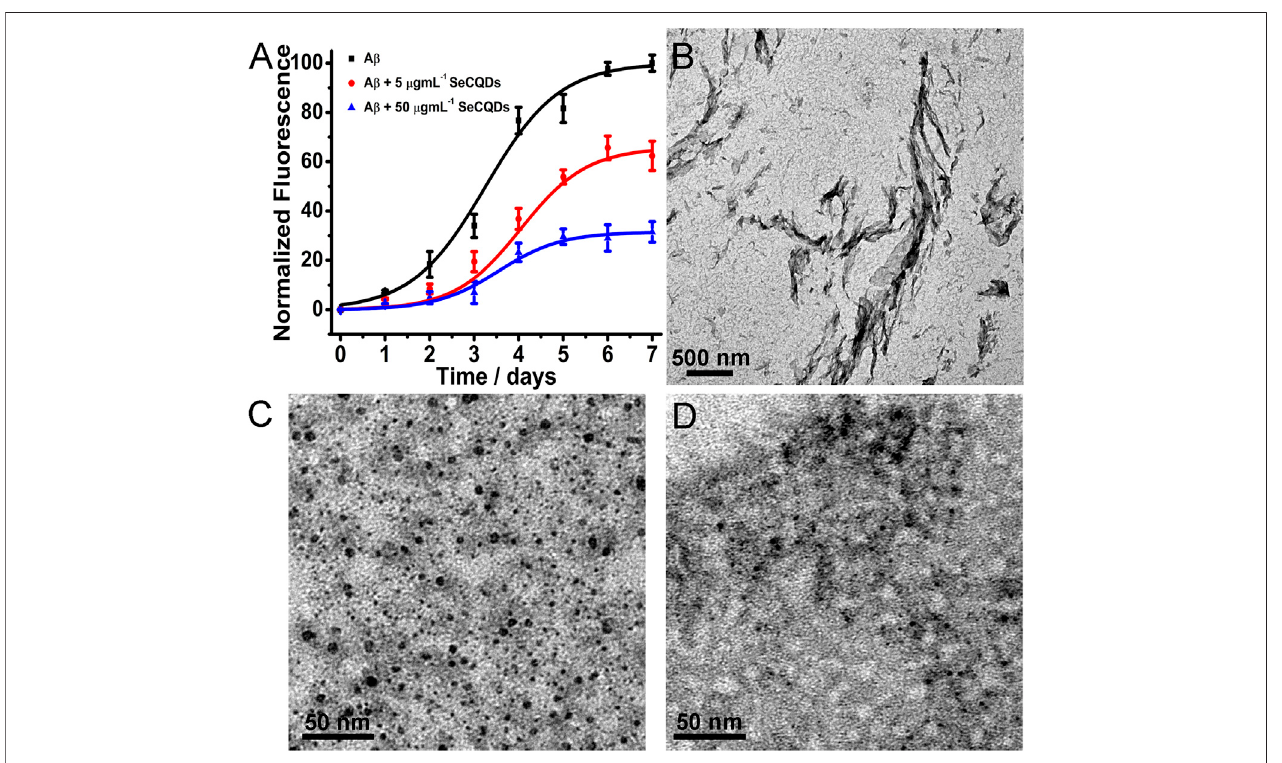
FIGURE 4 | Fibrillation kinetics of A β 40 in the absence or presence of SeCQDs monitored by ThT (A) . The A β 40 concentration was 100 μ M. The morphology of A β 40aggregateswasanalyzedbyTEMimages:100 μ M A β 40 (B) ,100 μ M A β 40inthepresenceof5 μ g ml − 1 SeCQDs (C) ,100 μ M A β 40inthepresenceof50 μ g ml − 1 SeCQDs (D) .